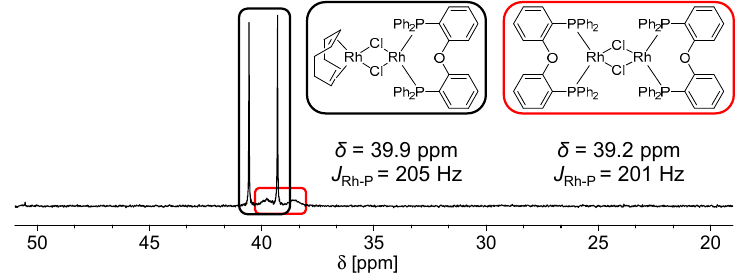
Figure 6. 31 P NMR spectrum of the solution obtained by dissolving crystals of [(COD)Rh( µ 2 -Cl) 2 Rh(DPEPhos)], black, in benzene- d 6 ; following the establishment of an equilibrium, [Rh(DPEPhos)( µ 2 -Cl)] 2 is formed, red.